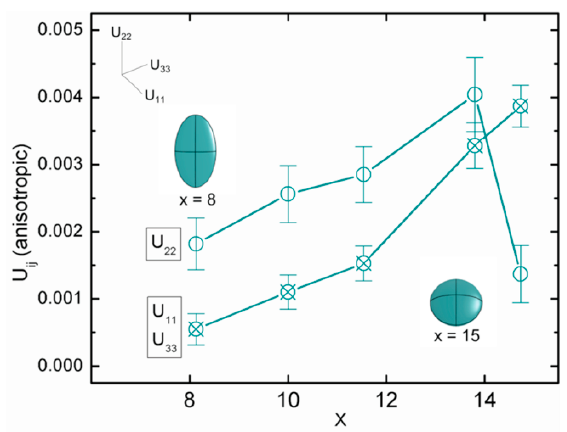
Figure 4. Anisotropic atomic displacement parameters (U 11 , U 22 , and U 33 ) of the 6 d site vs.